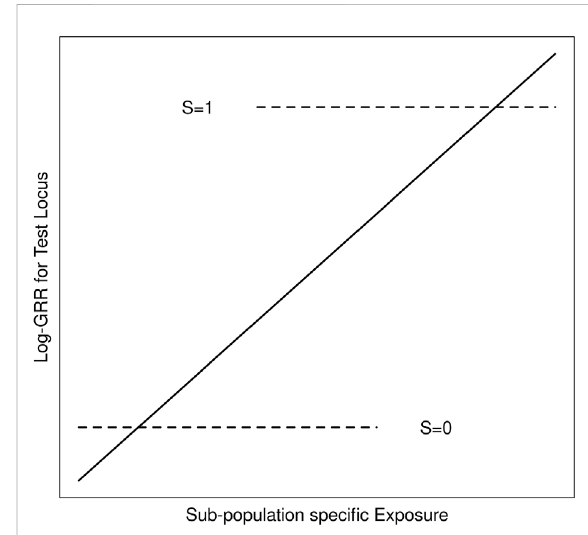
FIGURE 1 Schematic of log-GRRs for a non-causal test locus versus exposureinastructuredpopulationwithtwostrata,S=0andS=1. Dashed lines represent log-GRRs within each stratum. Horizontal positioning of these dashed lines indicates the support of the respective E distributions. High values of E are associated with S = 1, in which one of the alleles at the test locus is associated with increased disease risk. Low values of E are associated with S = 0 in which this same allele at the test locus is associated with low diseaserisk.IgnoringSyieldsthelinearlog-GRRcurveindicatedby the solid line, which erroneously suggests that E modi fi es the disease risk at the test